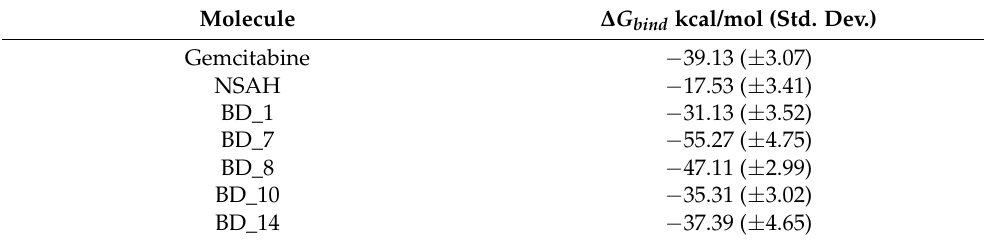
Table 6. Binding free energy of final five BTC molecules calculated from 100 ns MD simulation trajectory. Molecule ∆ G bind kcal/mol (Std. Dev.)